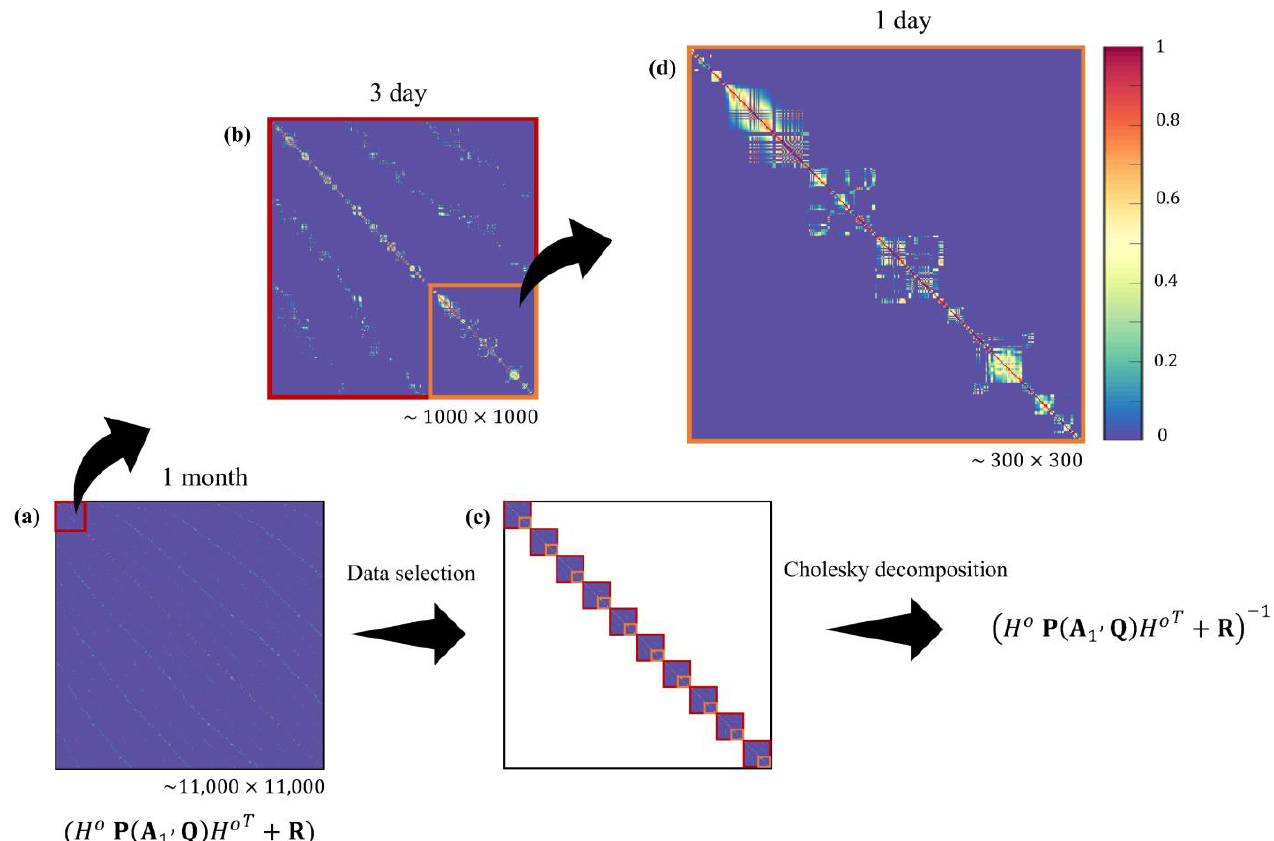
Figure A1. ( a ) One-month non-diagonal error covariance, H o P f H o T + R , is applied to the data selection procedure with ( b ) 3 days batch of observations to form ( c ) a block diagonal matrix of the same size. ( d ) Non-diagonal covariance matrix in one day.